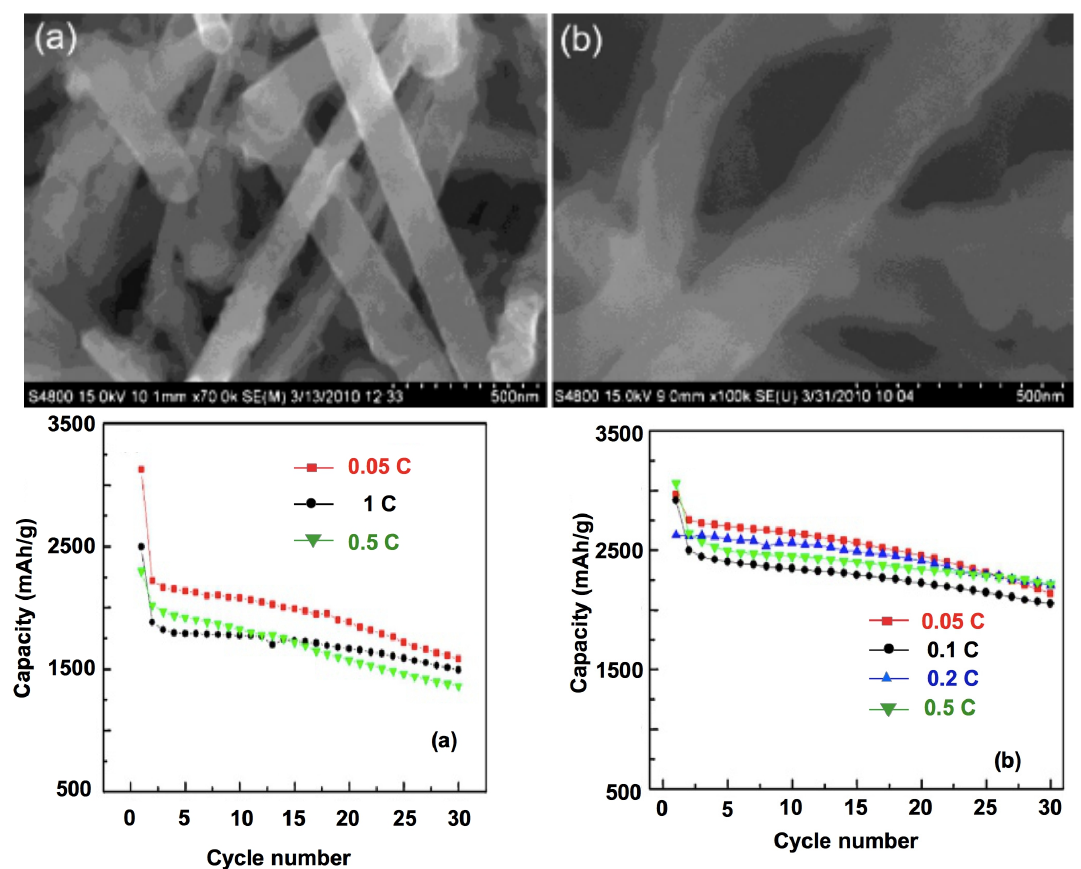
Figure 6. Top: SEM images of the silicon nanowires (Si Nws) ( a ) with and ( b ) without copper-coating after 100 cycles at the rate of 0.5 C ; Bottom: capacity–cycle number curves for Si nanowires ( a ) without and ( b ) with copper-coating at different rates. Reproduced with permission from [97]. Copyright Elsevier,